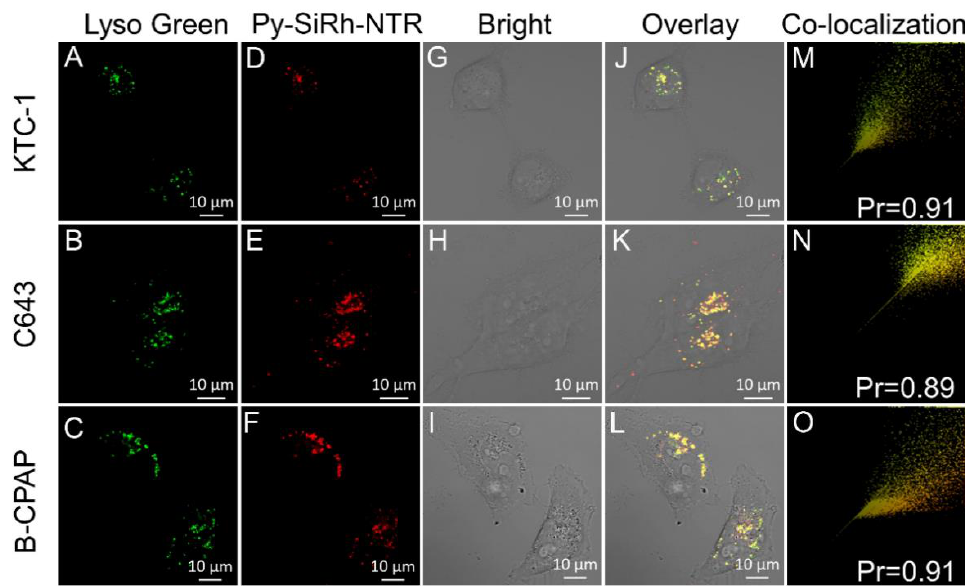
Figure 6. Co-localization of Py-SiRh-NTR and LysoTracker green in KTC-1, C643 and B-CPAP cells. The cells were incubated with Py-SiRh-NTR (2 µ M), and treated with LysoTracker green (200 nM). ( A – C ) The fluorescence from the LysoTracker green; ( D – F ) The fluorescence from the Py-SiRh-NTR; ( G – I ) Brightfield images of cells. ( J – L ) Merged image of images LysoTracker green and Py-SiRh-NTR . ( M – O ) Intensity correlation plot between Py-SiRh-NTR and LysoTracker green.